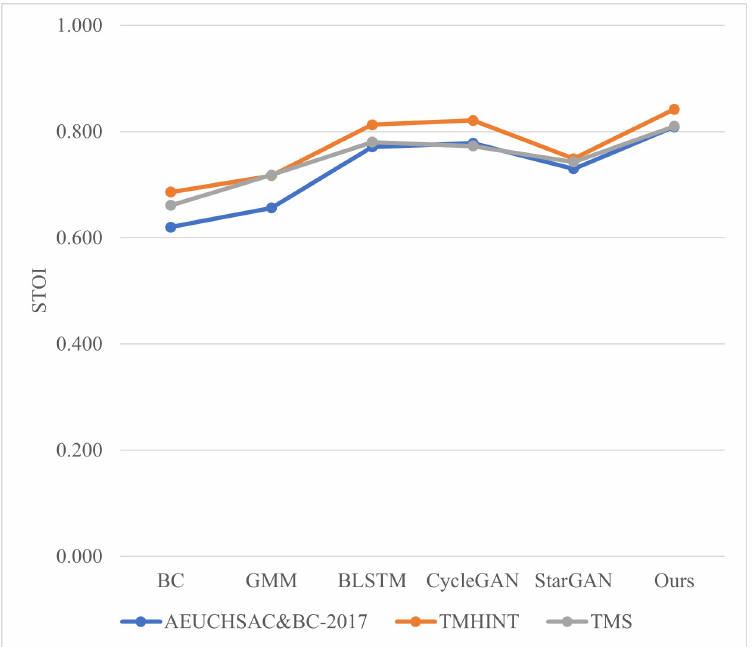
Figure 11. STOI scores of enhanced BC speech obtained by different methods.